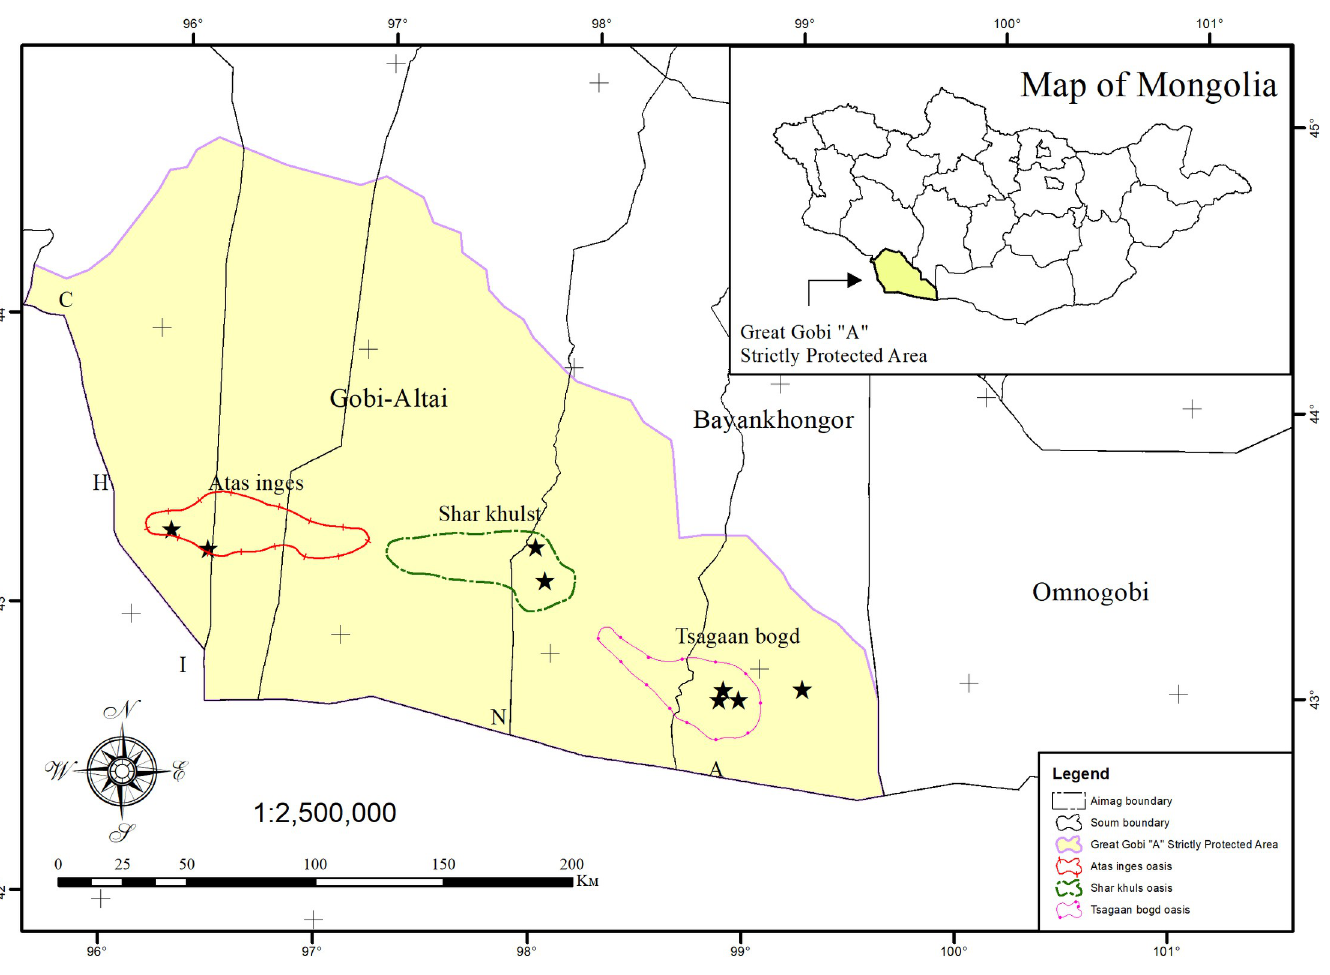
Fig 1. Location of sampling plots in GGSPA of Trans-Altai Gobi, Mongolia.